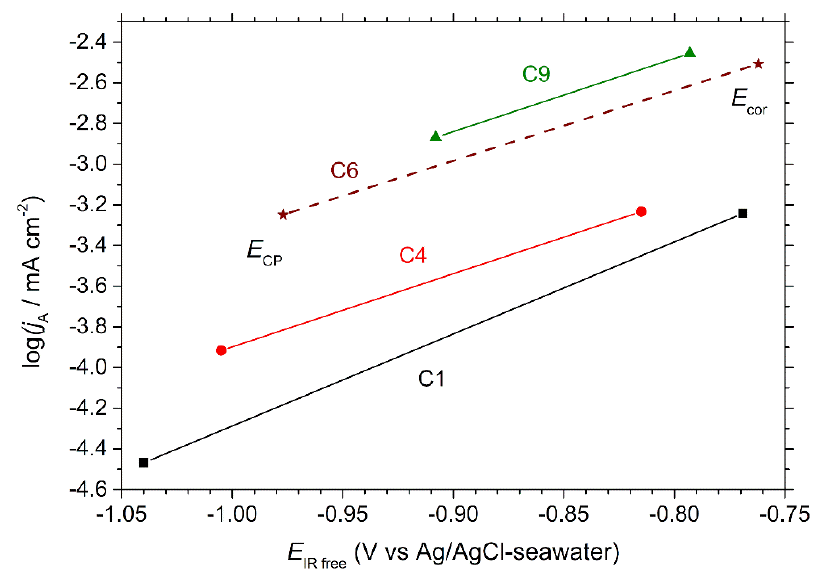
Figure 8. Anodic Tafel lines deduced graphically from the anodic branch of the polarization curves, extrapolated down to the last measured E CP value, and drawn between E CP and E cor for coupons C1 (black line), C4 (red line), C6 (brown dotted line) and C9 (green line). Table 3. Voltammetry measurements and data obtained via the extrapolation of the anodic Tafel line down to E CP . E cor is given in V vs. Ag/AgCl-seawater, j cor and j a ( E CP ) in mA cm − 2 , and the corro- sion rate and residual corrosion rate in µm yr − 1 .